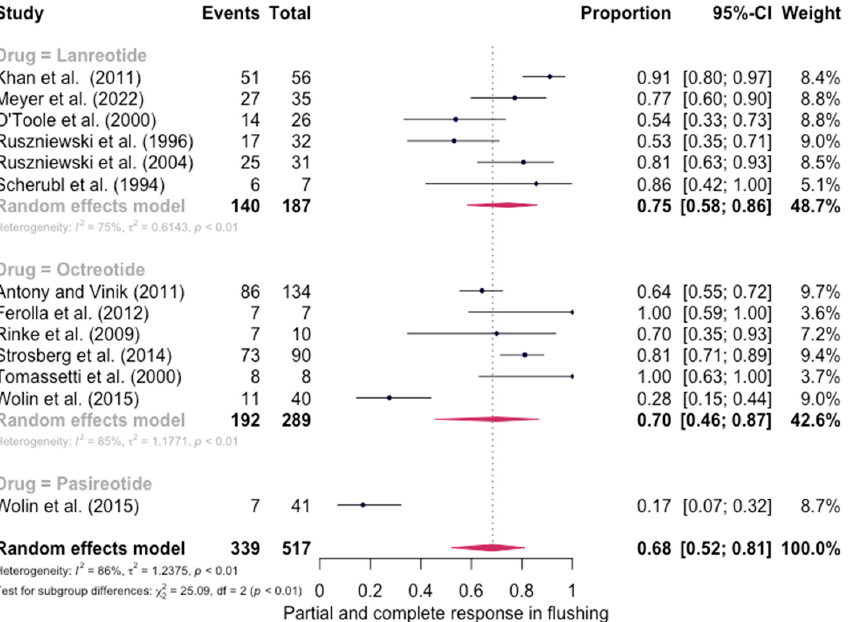
Figure 4. Forest plot demonstrating the pooled PR and CR for flushing in patients with carcinoid syndrome. CI: confidence interval, p: refers to Cochran’s Q test for heterogeneity [21,22,34,40,48-51,56,58-60] .